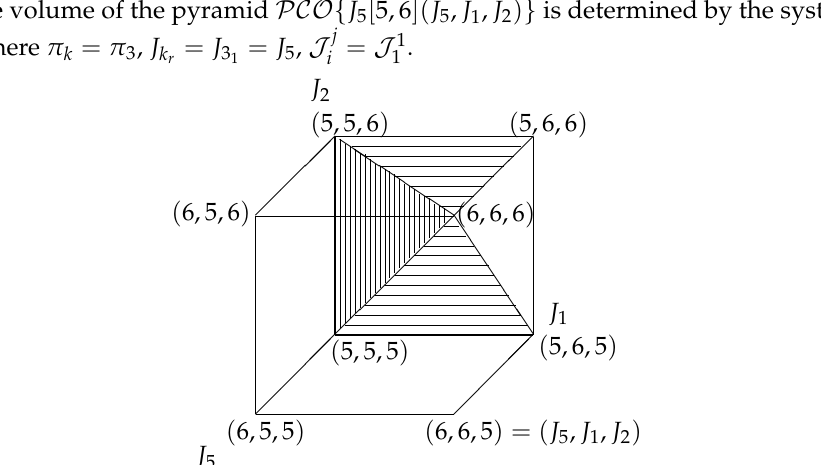
[ 5,6 ]( J ) } of the optimality subset 5 5 , J 1 , J 2